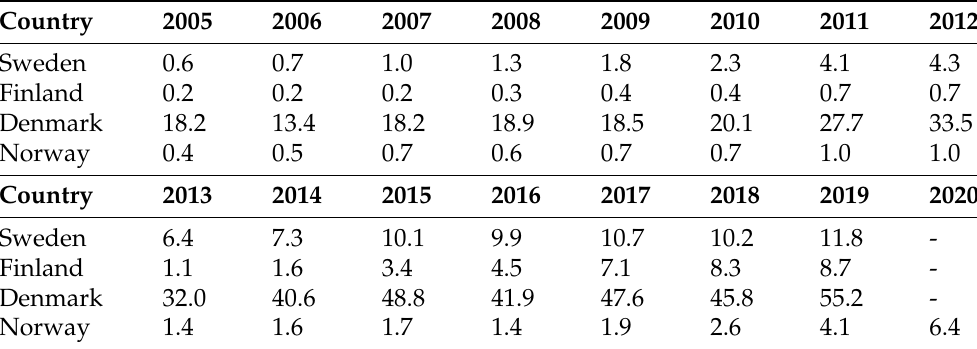
Table 12. Total wind power production in the Nordic countries in the years 2005–2019. Percent of total electricity production in the